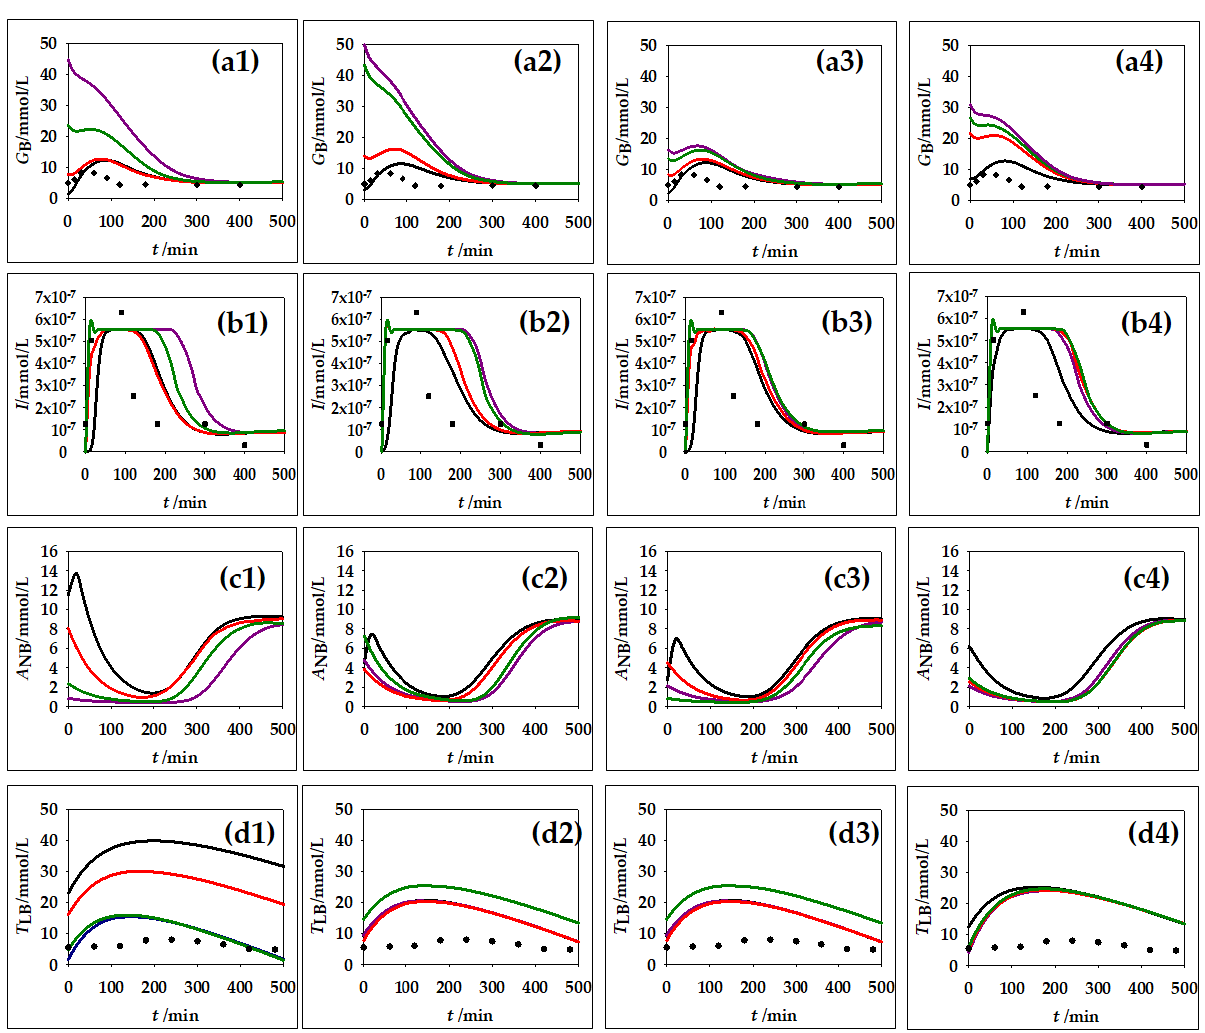
Figure 4. Results of hepatic lipid metabolism model simulations in CellDesigner software. ( a ) plasma glucose concentration, ( b ) plasma insulin concentration, ( c ) plasma non-esterified fatty acid concentration, ( d ) plasma endogenous lipoprotein triglycerides. Initial concentration for different